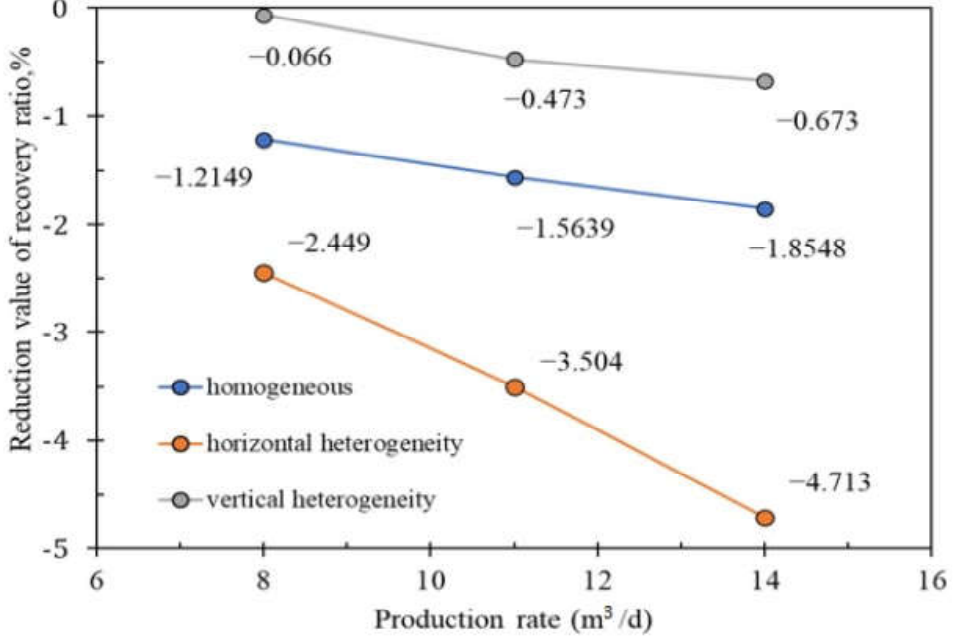
Figure 10. Reduction in dynamic capillary force for predicting oil recovery under different production